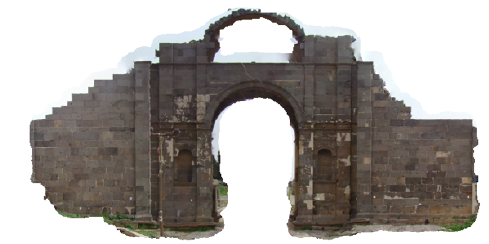
Figure 14. Evaluation distances for the Western gate